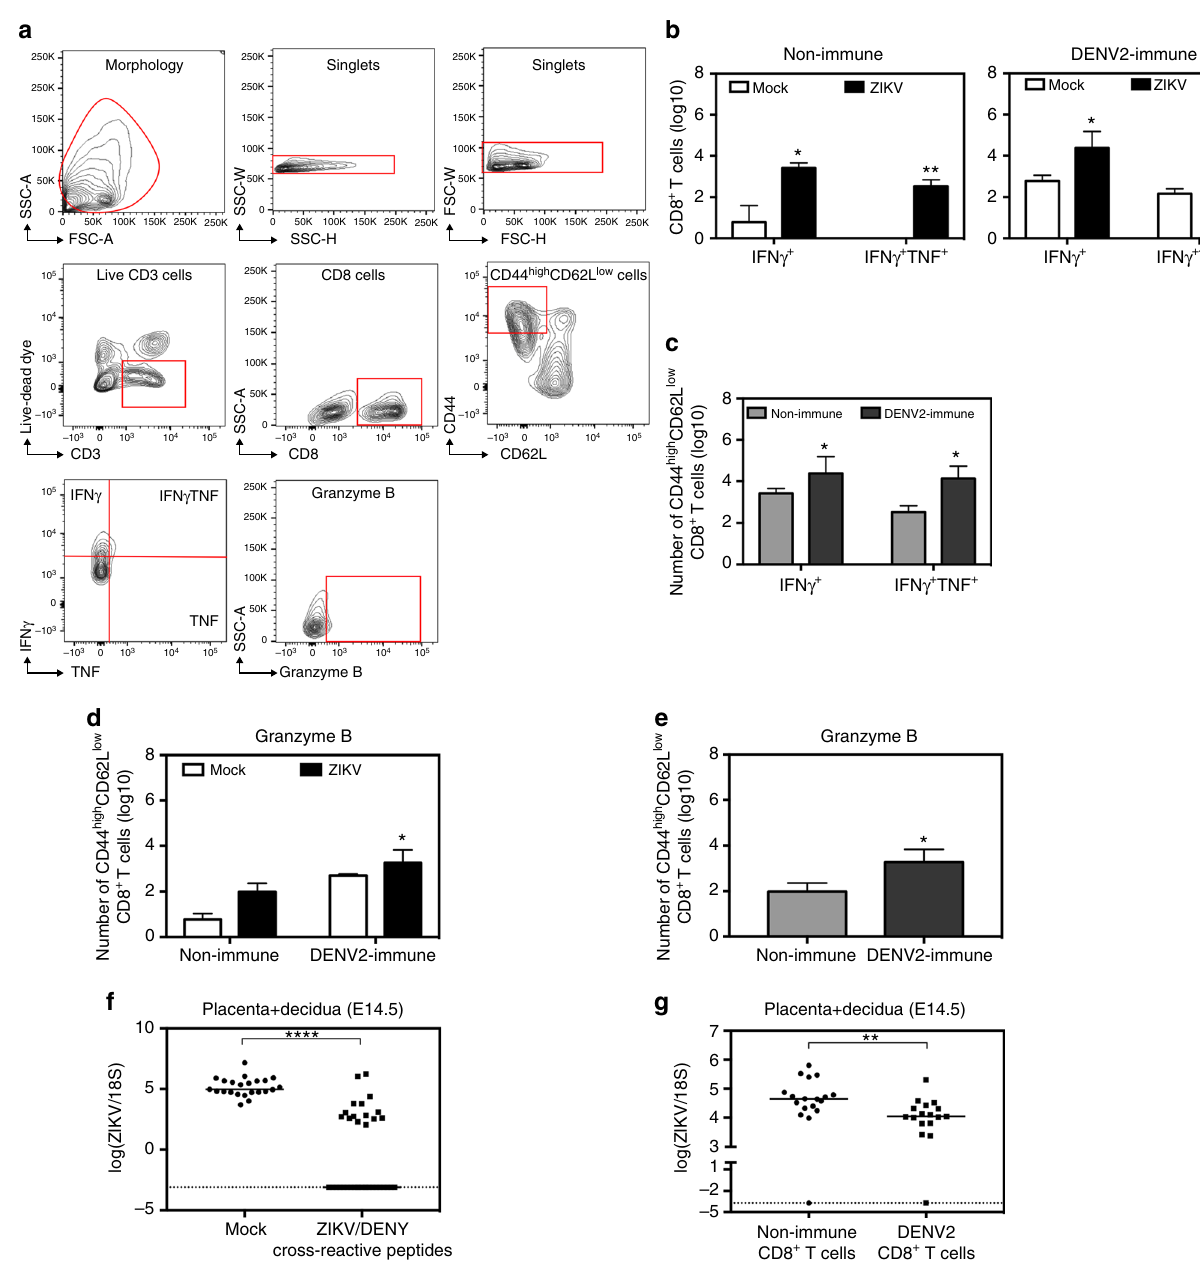
Fig. 7 Cross-reactive epitope-speci fi c CD8 + T cell response in placenta with decidua of non-immune or DENV2-immune Ifnar1 mAb-treated WT dams 7 days after ZIKV infection. a – e Non-immune or DENV2-immune WT dams with Ifnar1 blockade were challenged with ZIKV at E7.5 as described in Fig.